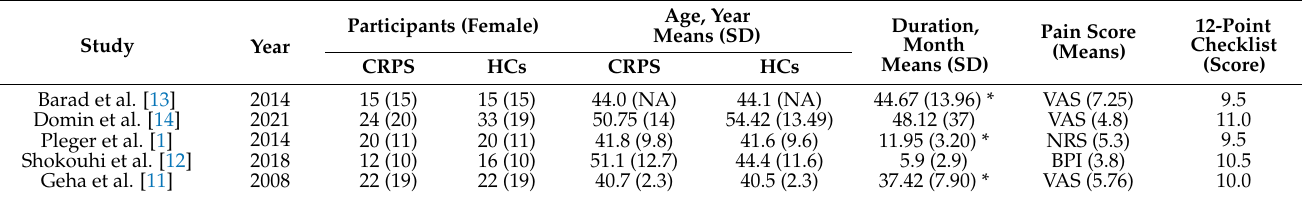
Figure 1. The search flow diagram following PRISMA guidelines. Table 1. Demographic information of five studies included.